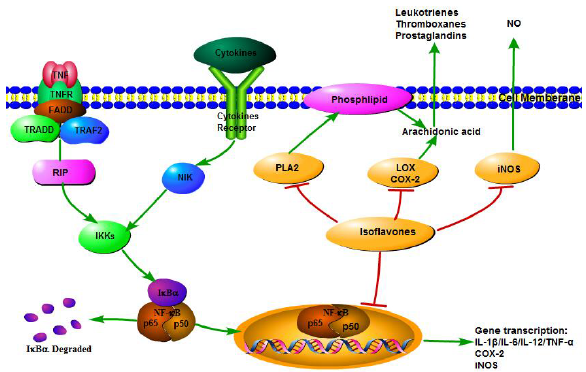
Figure 2. Anti ‐ inflammatory mechanisms of isoflavones. Upon stimulation, cytoplasmic NF ‐κ B is Figure 2. Anti-inflammatory mechanisms of isoflavones. Upon stimulation, cytoplasmic NF- κ B activated by I κ B kinase (IKK). Then, free NF ‐κ B translocates into the nucleus and activates the is activated by I κ B kinase (IKK). Then, free NF- κ B translocates into the nucleus and activates the transcription of target genes including pro-inflammatory cytokines and chemokines, inducible nitric oxide synthases (iNOS), and cyclooxygenase 2 (COX-2). Isoflavones decrease the production of these pro-inflammatory contributors by inhibiting the NF- κ B transcriptional system. Also, isoflavones activities of pro ‐ inflammatory enzymes (phospholipase A2 (PLA2), lipoxygenase (LOX), COX ‐ 2, and modulate arachidonic acid (AA) metabolism and NO production by inhibiting the protein levels and activities of pro-inflammatory enzymes (phospholipase A2 (PLA2), lipoxygenase (LOX), COX-2, and iNOS). The metabolites of AA—including prostaglandins (PG), leukotrienes and thromboxances, and NO—are crucial mediators of